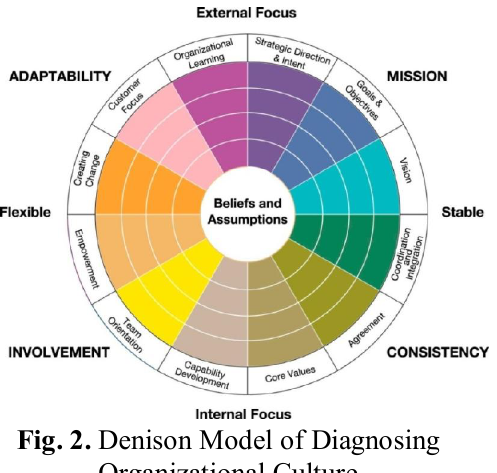
Fig. 2. Denison Model of Diagnosing Organizational Culture